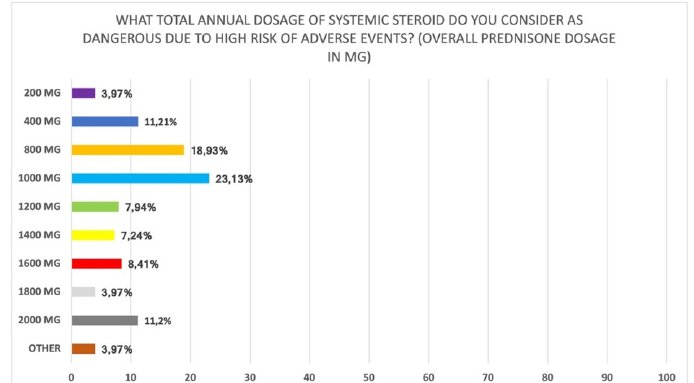
Figure 5 Total annual dose of corticosteroids considered at high risk of adverse events (Q29 of Sup- plementary Materials